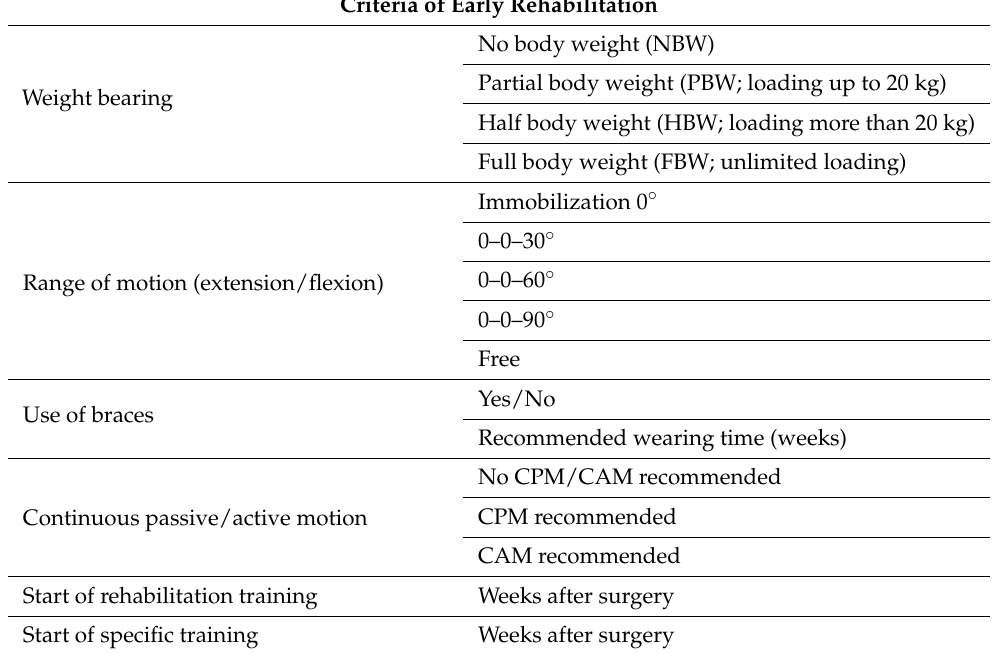
Table 1. Criteria of early